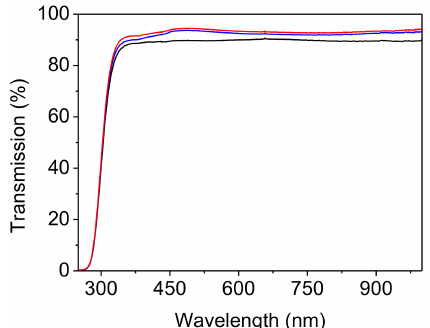
Figure 6. Visible spectra of some of the samples studied. Black line: uncoated common glass slide. Blue line: glass slide coated with La(Ac) 3 doped silica. Red line: glass slide coated with La(NO 3 ) 3 doped silica.